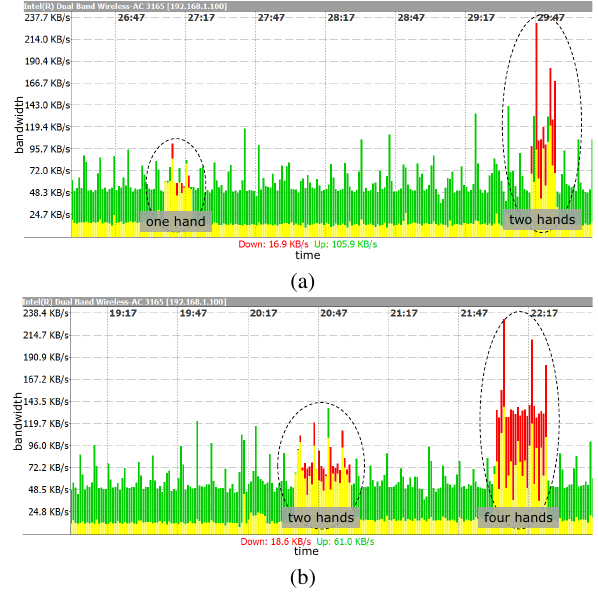
Figure 5. Bandwidth that is measured on the Cardboard server in a scenario with three users connected to the same VR environment: one user is the server and the others are the clients. The two graphs show the bandwidth variations on the server (a) when one client interacts with one hand first and then two hands, and (b) when two clients both interact with one hand first and then two hands. Red bars are the bandwidth utilised by the server to download leap- frames from the clients. Green bars are the bandwidth utilised by the server to upload (broadcast) leap-frames to the clients. Yellow bars are used to represent the overlap between the download and